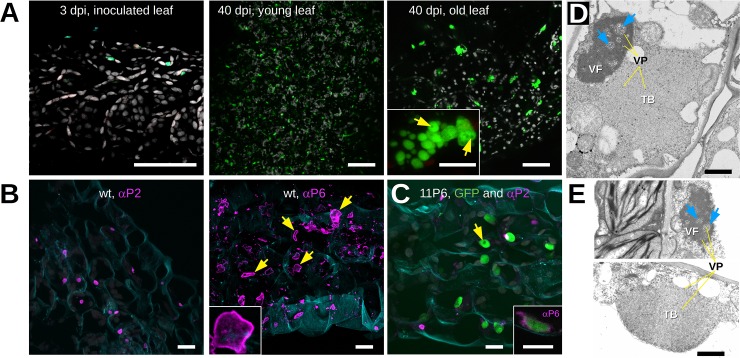
Microscopic analysis of CaMV11P6-infected A. thaliana.(A) Arabidopsis thaliana GFP1-10 leaves were analyzed by confocal fluorescence microscopy at 3 and 40 days after inoculation (dpi) with CaMV11P6. GFP fluorescence and chloroplast autofluorescence are presented in green and grey, respectively. The greenish spots in the leaf tissue at 3 dpi are not due to GFP since they also fluoresced in blue when excited at 405 nm. The inset in the third panel shows details of an 11P6 inclusion in which darker circular spots are visible (yellow arrows). (B) CaMVwt-infected tissue sections were immunolabeled (magenta) at 28 dpi using the antisera (αP2 or αP6) as indicated. The yellow arrows point to the stronger stained cortex of immunostained VFs, the inset presents details of a VF. (C) CaMV11P6-infected tissue was immunolabeled at 40 dpi using P2 antiserum (magenta) and 11P6 was visualized by fluorescence of the reconstituted split GFP (green). The inset shows a confocal single section of such a green fluorescing inclusion labeled with P6 antiserum (magenta). Note that only the cortex of the inclusion is labeled. The yellow arrows point to putative VF lacunae. Cell walls in (B) and (C) were stained with Fluorescent Brightener 28 and are presented in blue. All confocal images are maximum projections except where indicated. (D) and (E) Transmission electron micrographs presenting (D) a CaMVwt and (E) a CaMV11P6-infected cell, both fixed at 33 dpi. VF and TB designate virus factories and transmission bodies, respectively; yellow lines (labeled “VP”) and blue arrows point to virus particles and lacunae, respectively. Different microscopes were used for image acquisition in (D) and (E). Brightness and contrast were corrected to allow better comparison of the micrographs. Scale bars in (A) 50 μm for the overviews and 5 μm for the inset, in (B) and (C) 10 μm and in (D) and (E) 1 μm.